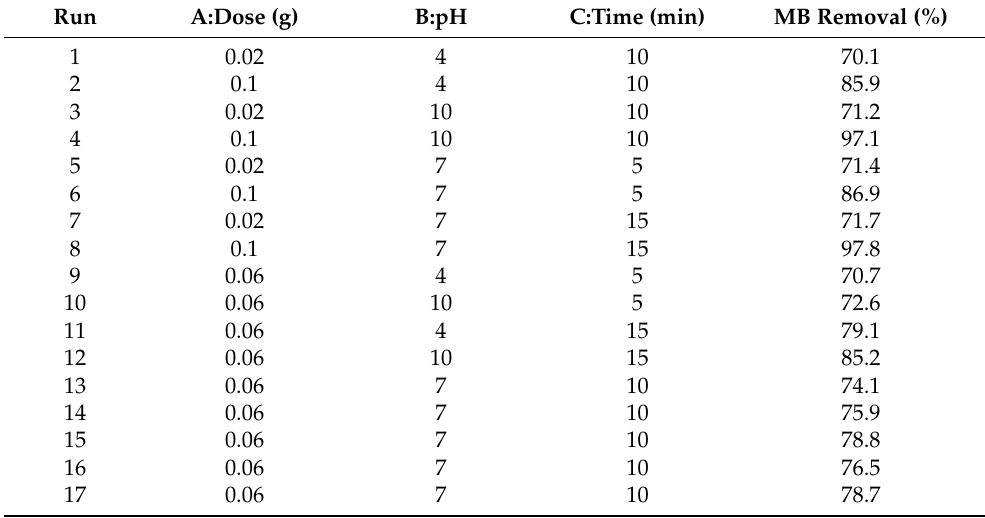
Table 2. Experimental matrix of BBD and corresponding quadratic model response (MB removal).